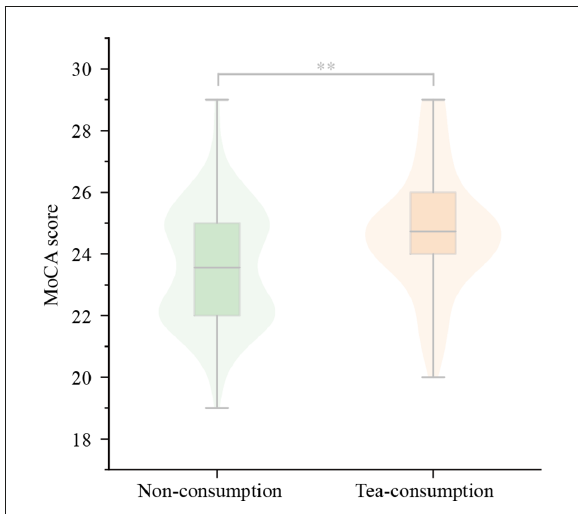
FIGURE3 The difference for MoCA score between non-consuming group and tea-consuming group. The MoCA score was higher in the tea-consuming group significantly. MoCA, Montreal Cognitive Assessment scale. ∗∗ P < 0.001.